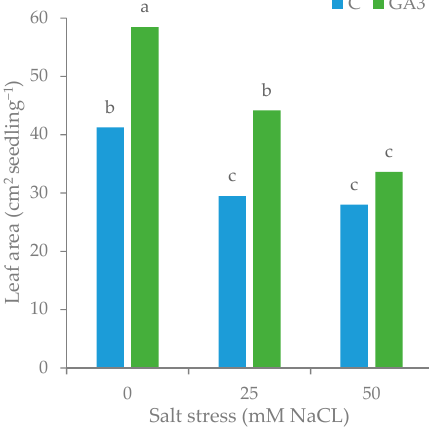
Treatment z Each value is the mean of 4 replicated samples of 30 seedlings each. For each factor, values in a column followed by different letters are significantly different, according to the LSD test. x